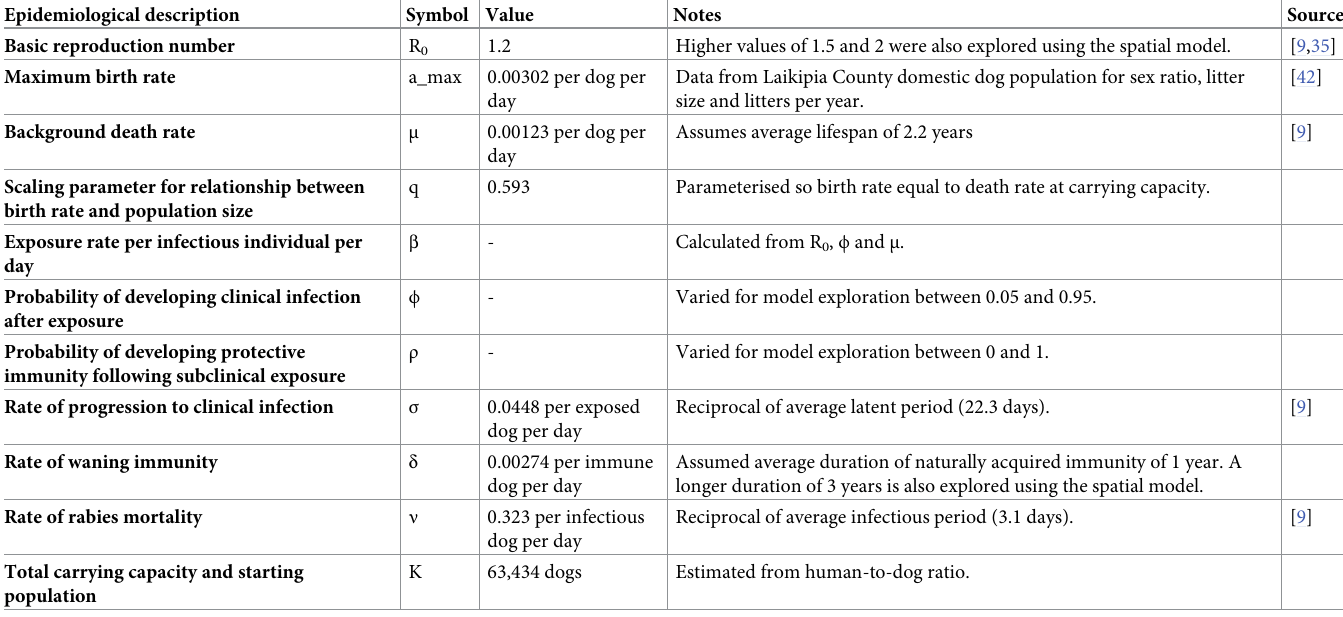
Table 1. Non-spatial model parameter values. Sensitivity analysis was conducted for all parameters in the non-spatial model, excluding R 0 and K which were kept con- stant, and q and β , which were calculated from other parameters. Sensitivity analysis results are presented in the S2